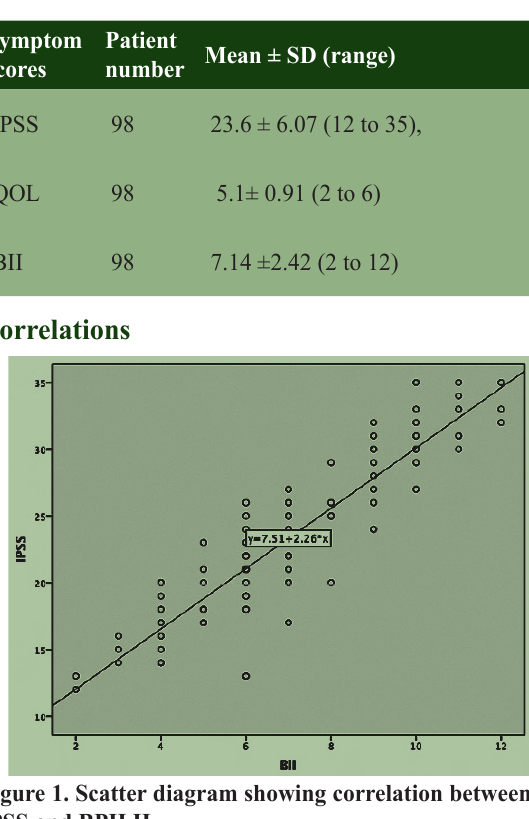
Table 2. Descriptive statistics showing mean values and range of symptom scores